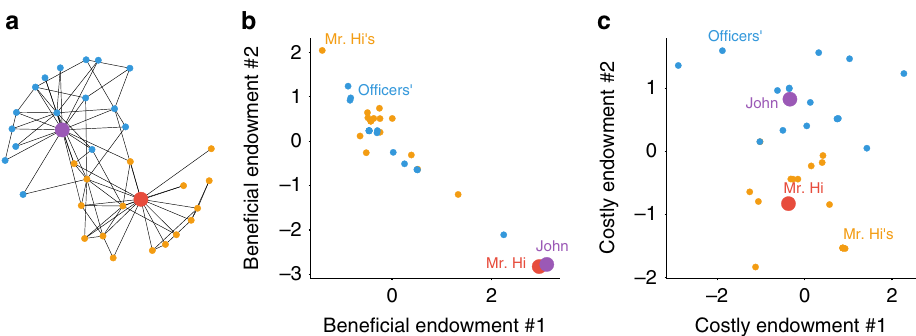
Fig. 1 Illustration of the learned endowments for karate club network. a The network structure of karate club network. Mr. Hi, the instructor, is marked red, and other people in his faction are marked orange. John, the student leader or of fi cer, is marked purple, and other people in his faction are marked blue. b The fi rst two dimensions of the learned endowment vector for each individual; these two dimensions are only related to exchange bene fi ts so we call them “ bene fi cial endowments ” . c The last two dimensions of the learned endowment vector for each individual; these two dimensions are only related to coordination costs so we call them “ costly endowments ”